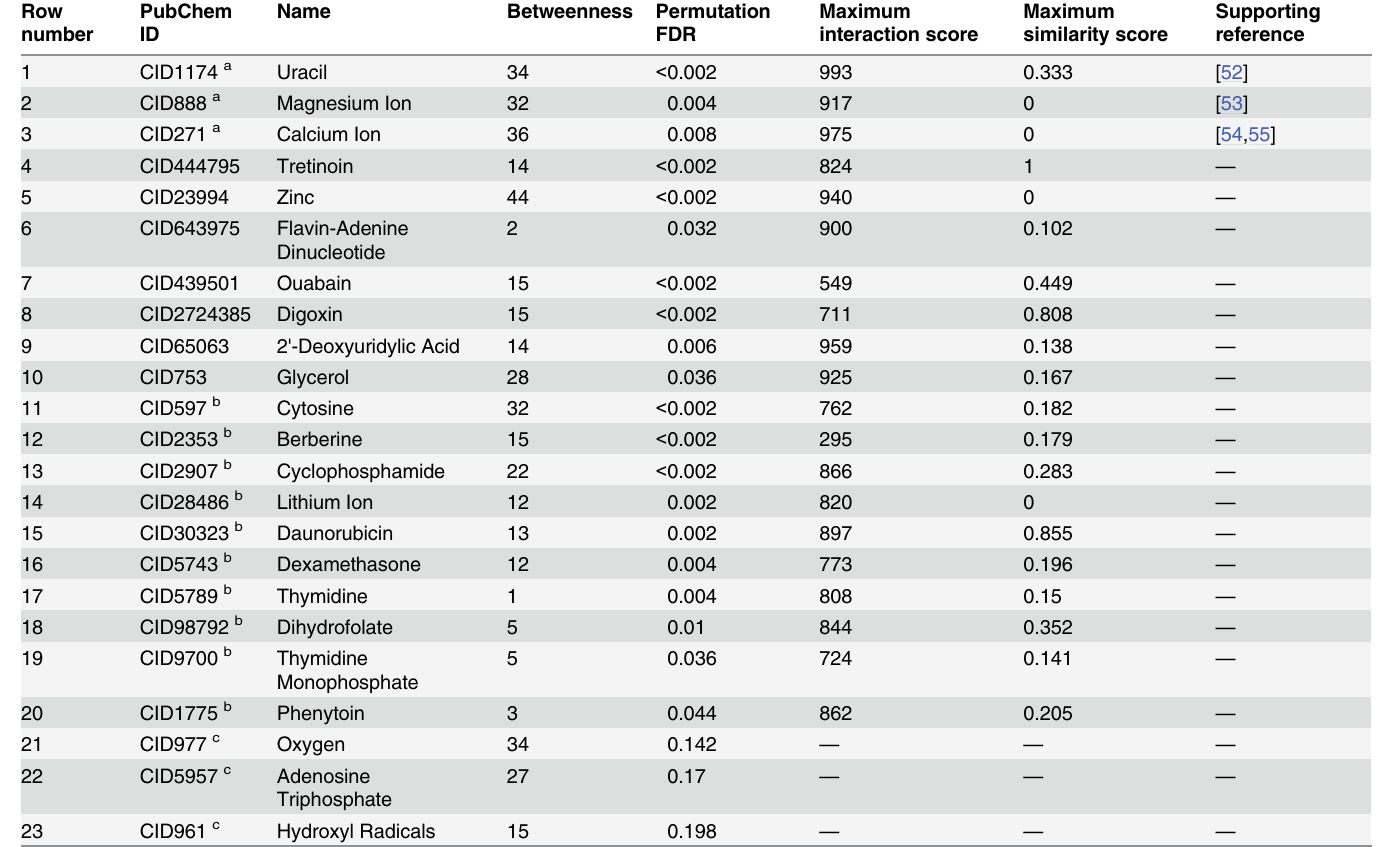
Table 2. Detailed information of 23 candidate chemicals for